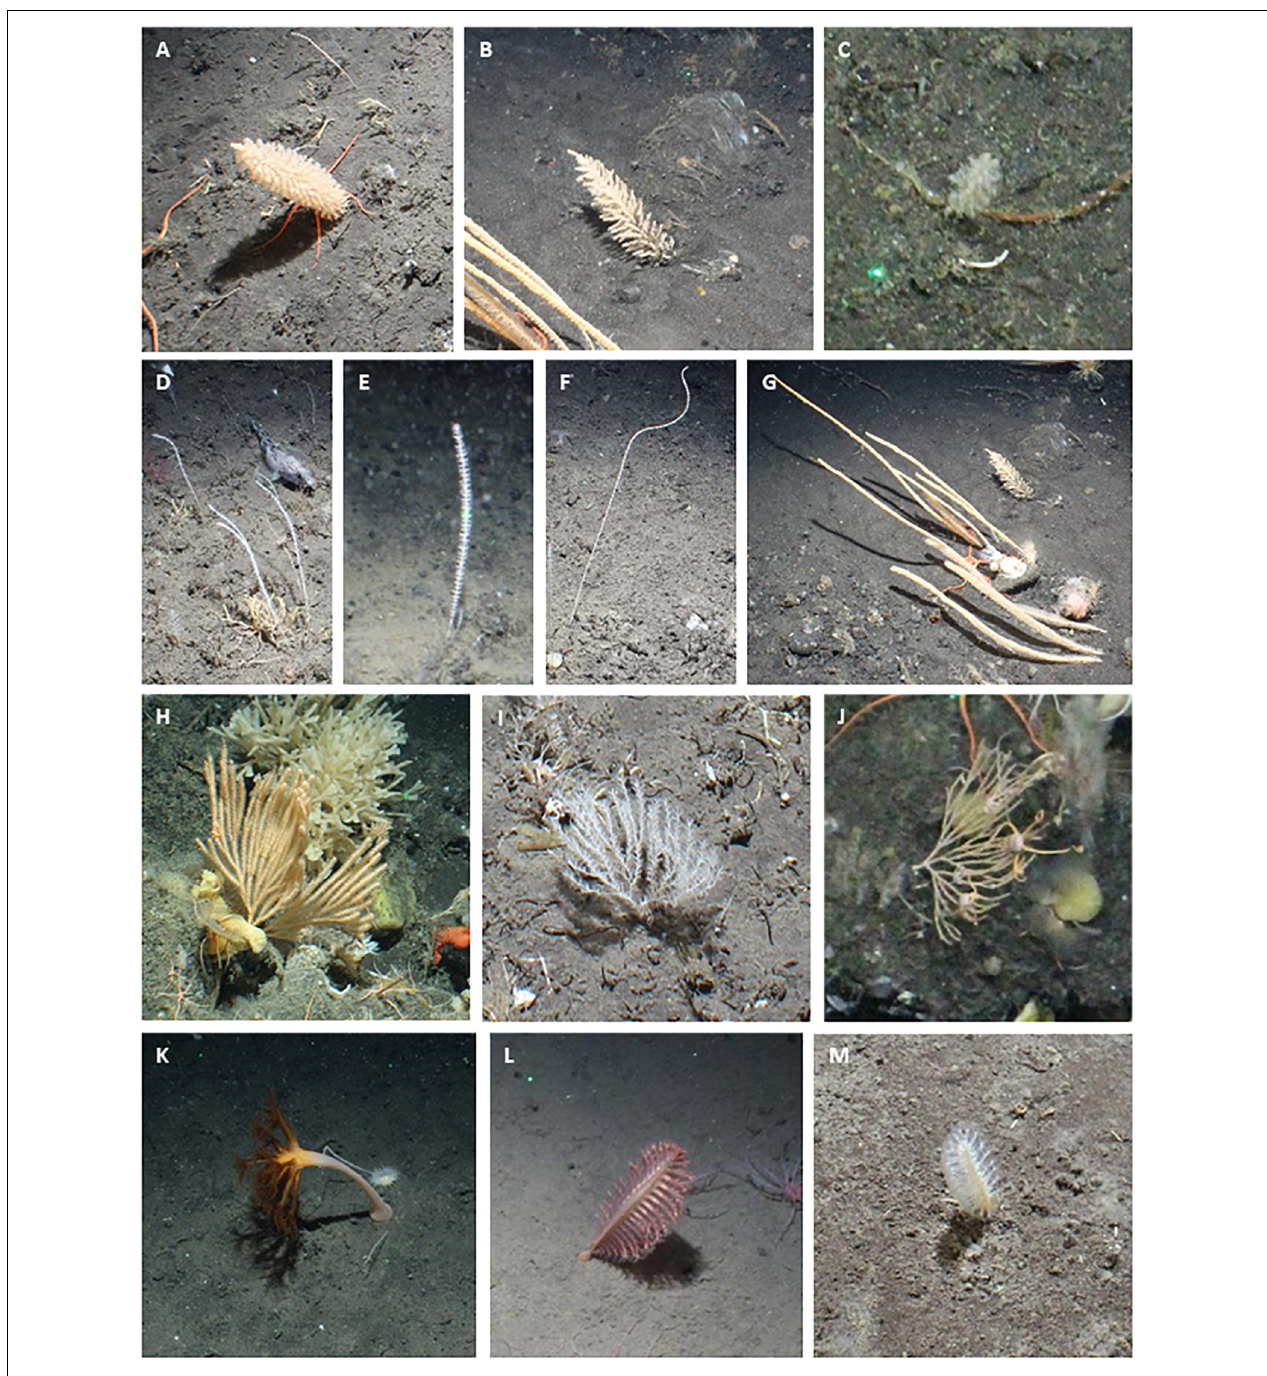
FIGURE 3 | Photographs showing examples of selected VME indicator taxa observed at the South Sandwich Islands. (A–C) bottlebrush corals; (D–G) whip corals; (H–J) branching corals; (K) sea pen, Umbellula sp.; (L) sea pen, Pennatula sp.; (M) sea pen,